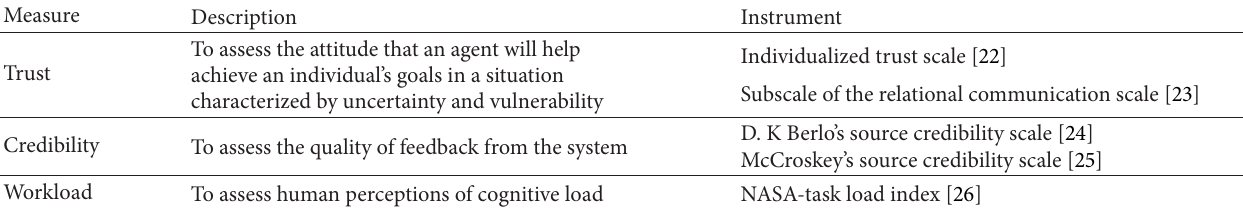
Table 1: Typical subjective attitudes towards a robot and the respective